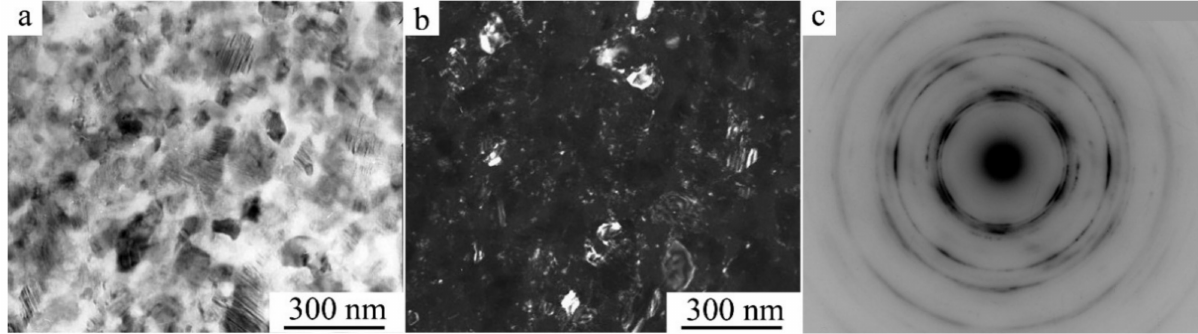
Figure 10. ( a ) Bright- and ( b ) dark-field TEM images of the microstructure and ( c ) the corresponding SAED pattern for the Cu–14Al–3Ni alloy after its quenching from 1223 K and HPT of 10